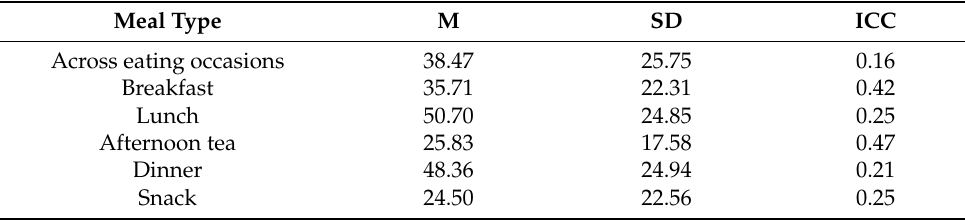
Table 1. Descriptive statistics for meal colour variety.